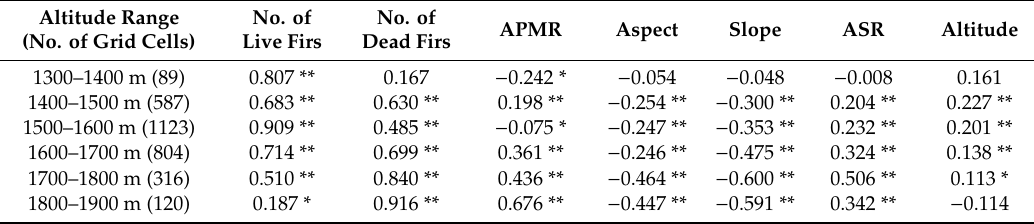
Table 8. Pearson correlation analysis between density of Korean fir and other factors within each 100 m altitudinal